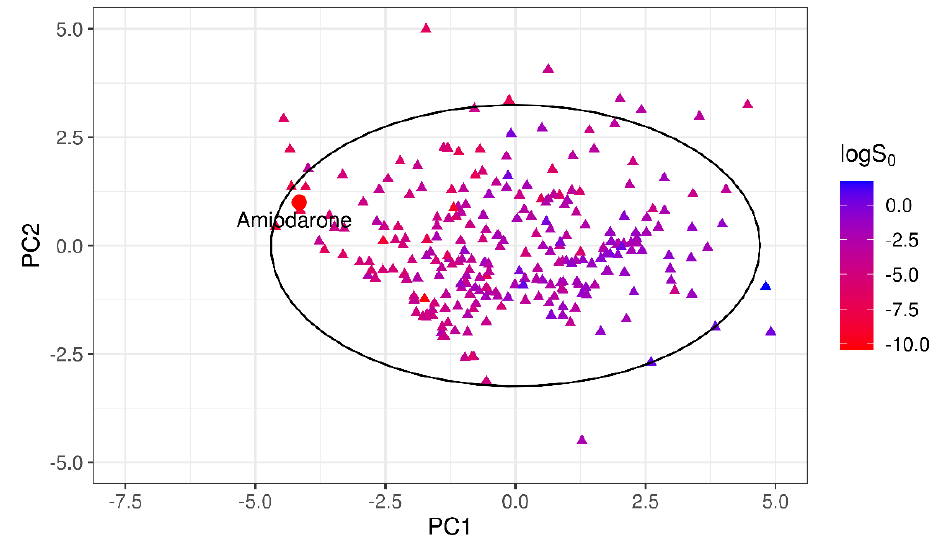
Figure 7. Projection of the test 2 outliers in the PC1–PC2 dimensional space. Although inside the 95% CI of the training dataset, amiodarone clearly laid in a sparsely populated area of the training chemical space, as confirmed by the values of the Euclidean similarity index. As for the test set 1 outliers, the 10 nearest neighbors of amiodarone ( logS 0 = − 10.4 log molar) based on the Euclidean similarity index were considered. They showed a high variance in terms of logS 0 , with a range of − 9.27 to − 0.1, and a mean of − 4.53 log unit. The predicted amiodarone solubility was − 6.72 log molar, barely higher than the mean solubility value of the 10 NN.